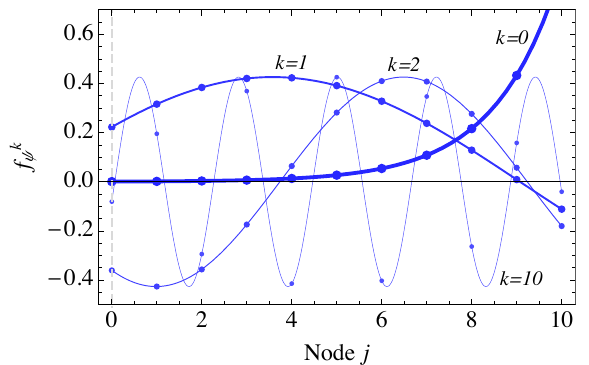
Figure 2 . The pro(cid:12)les of the zero mode, 0 from thicker to thiner lines), in the case of clockworking a single fermion, R , for N = 10 nodes with q = 2. The values of the pro(cid:12)les on each of the N + 1 nodes are denoted with a blue dot.